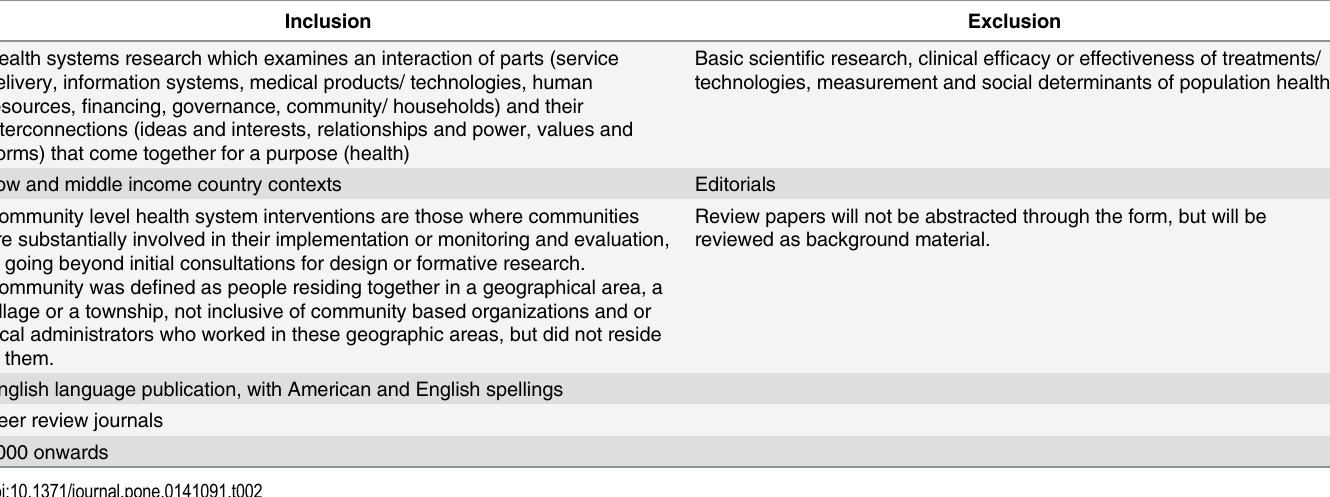
Table 2. Inclusion and exclusion